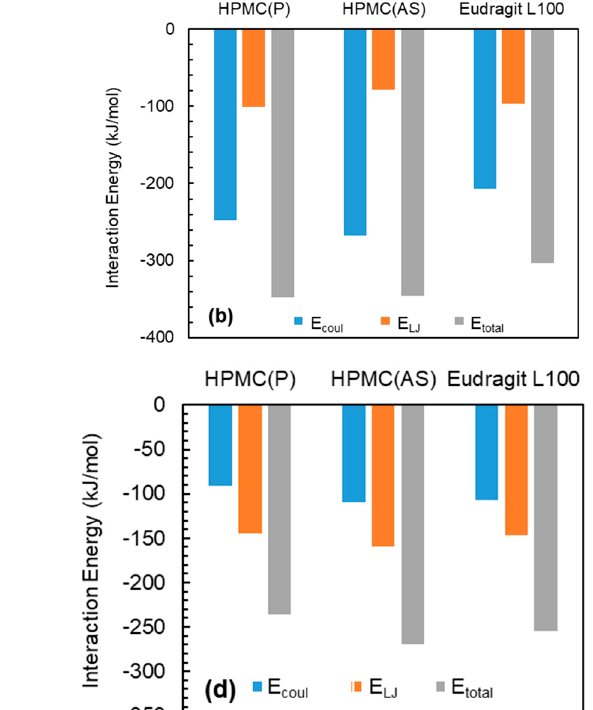
Figure 5. Radial distribution functions, g ( r ) of Eudragit L100 around Eudragit L100 and HPMC(AS) around HPMC(AS) in a mixture of these excipients with ( a ) DMF and ( b ) OPZ. The E L100 and HPAS in the fi gure legend indicate Eudragit L100 and HPMC(AS), respectively. The insets provide a zoomed-in view of the red circled portion.